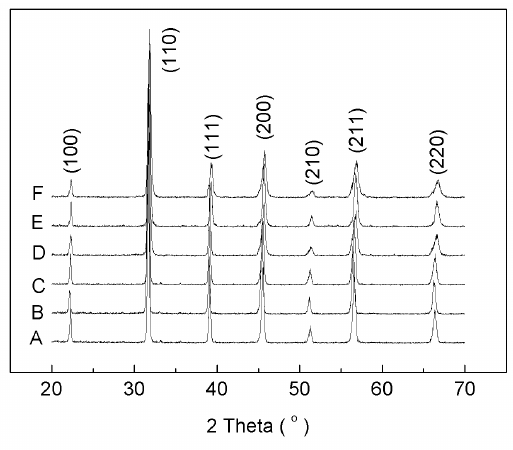
Fig. 2 The diffraction pattern of samples A-F